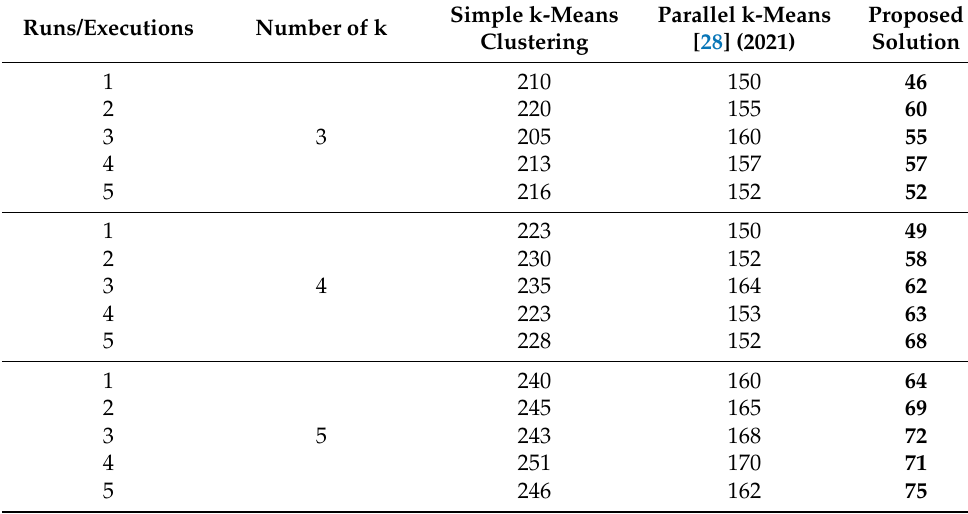
Table 8. Time elapsed for k clustering in